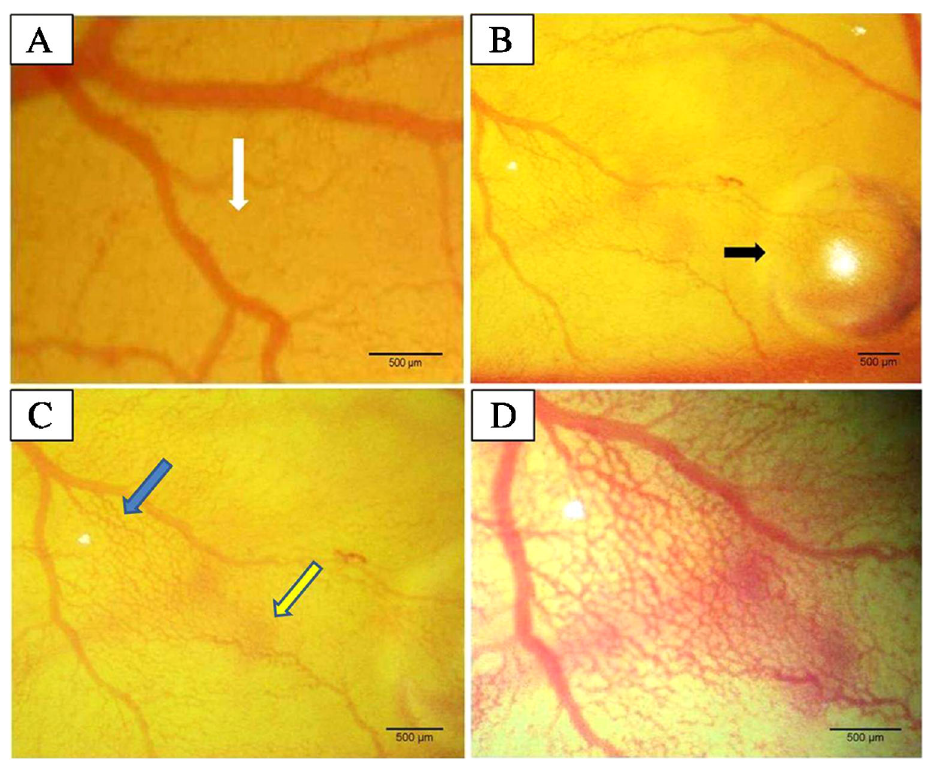
Figure 1. Inoculation site of P1.HTR cells on chick embryo chorioallantoic membrane (CAM) ( A ). Note the blood vessel-free area between large CAM vessels (white arrow). Thirty minutes after inoculation, a small bubble persists and the surrounding vessels become more evident ( B , black arrow), with a pronounced hyperemia (blue arrow) and spotted hemorrhagic area (yellow arrow) 6 h later ( C ). ‘‘Cobblestone-like’’ pattern of blood vessel distribution 24 h post-inoculation ( D